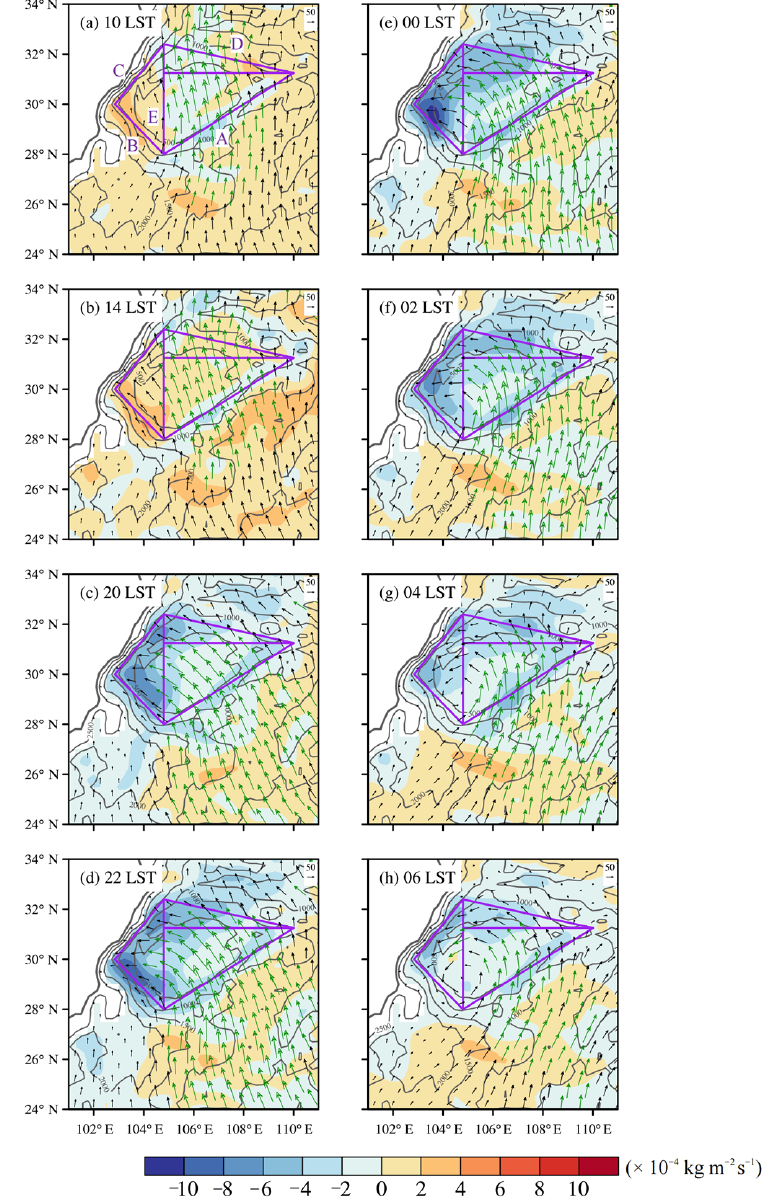
Figure 13. Diurnal variations of the total moisture flux (arrows) and the moisture flux divergence (shaded) from surface—700 hPa at ( a ) 10 LST, ( b ) 14 LST, ( c ) 20 LST, ( d ) 22 LST, ( e ) 00 LST, ( f ) 02 LST, ( g ) 04 LST, and ( h ) 06 LST. Purple lines in Figure 13a represent boundaries A, B, C, D, and E. Green arrows represent the moisture flux larger than 100 kg m –1 s –1 .